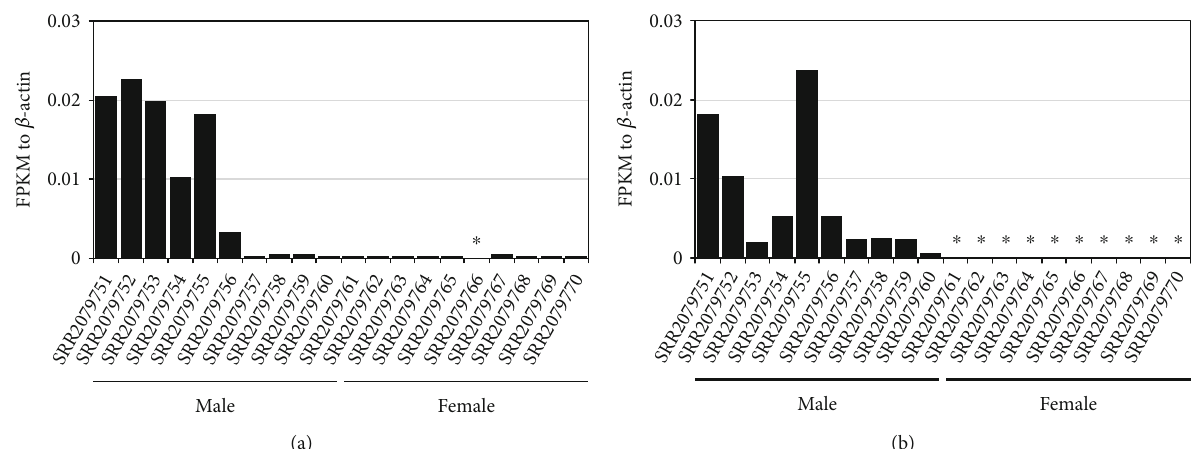
Figure 10: Expression of sult1st6 in southern blue fi n tuna ’ s gonad cells. (a) sult1st6a and (b) sult1st6y . Asterisks indicate that the expressions were undetectable ( FPKM = 0